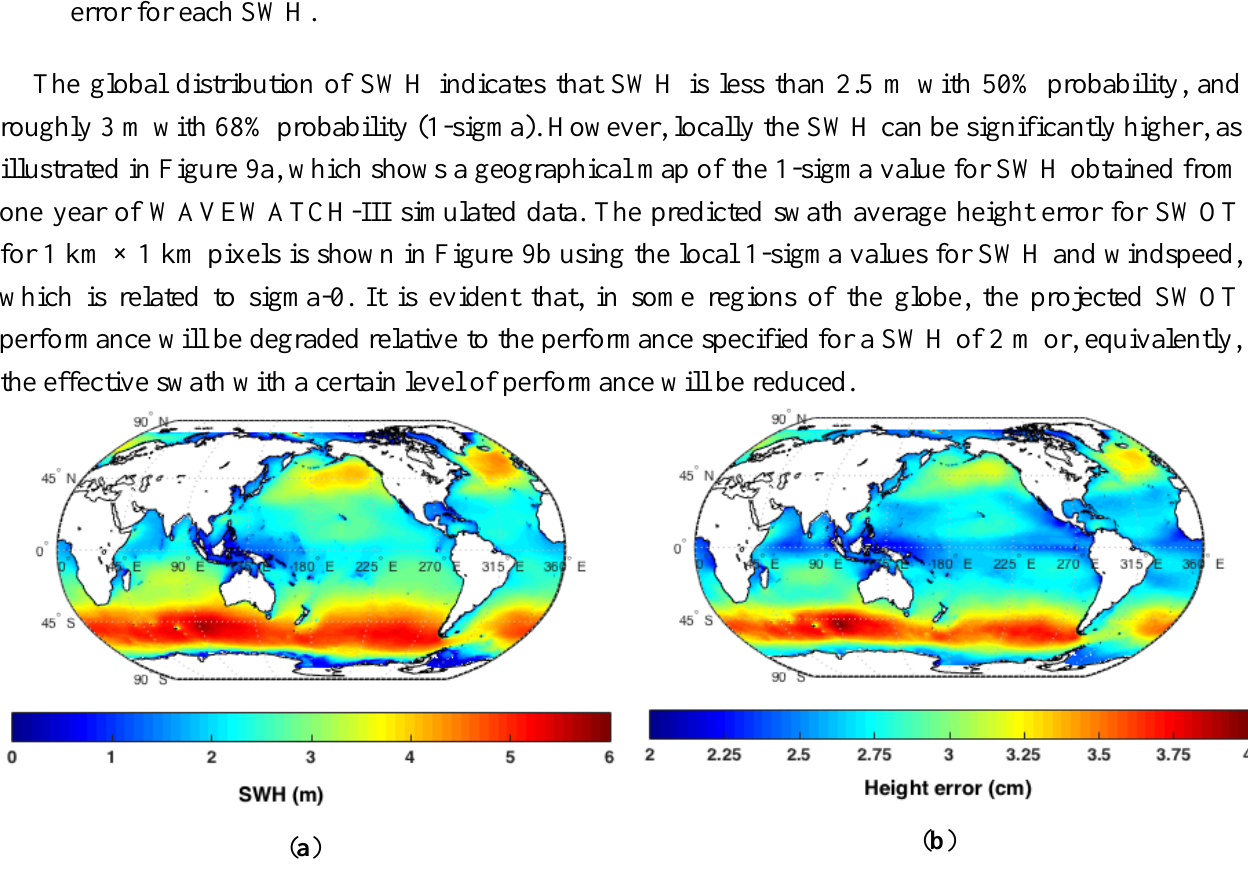
Figure 9. ( a ) Significant Wave Height (SWH) 1 sigma (68%) value based on one year of WAVEWATCH-III simulations. ( b ) Swath average height error for 1 km × 1 km